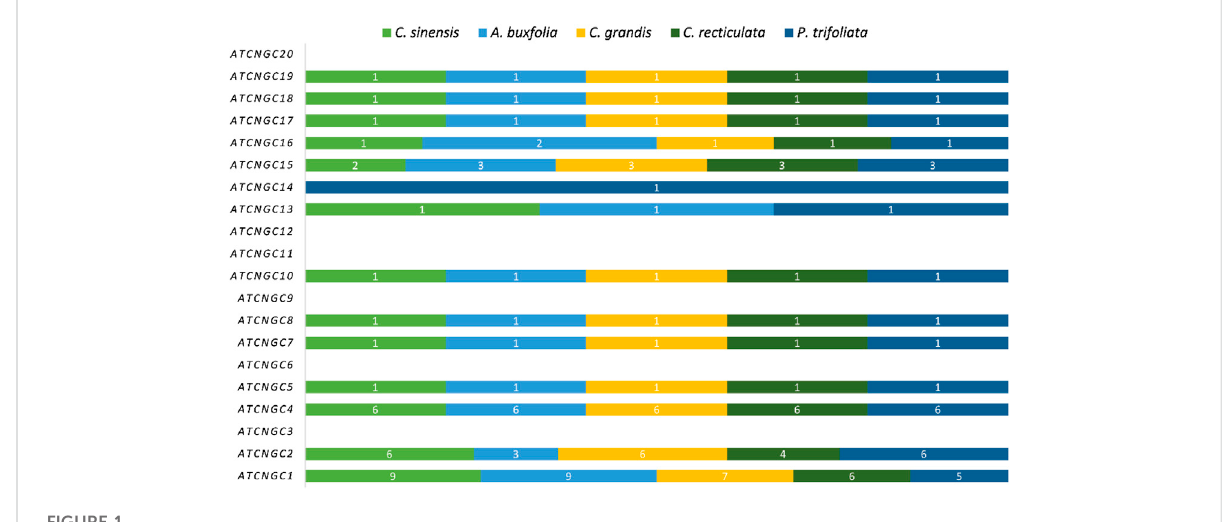
FIGURE 1 Bar Plot showing homologs of Arabidopsis CNGCs present in fi ve Citrus species. Each species is having a variable number of